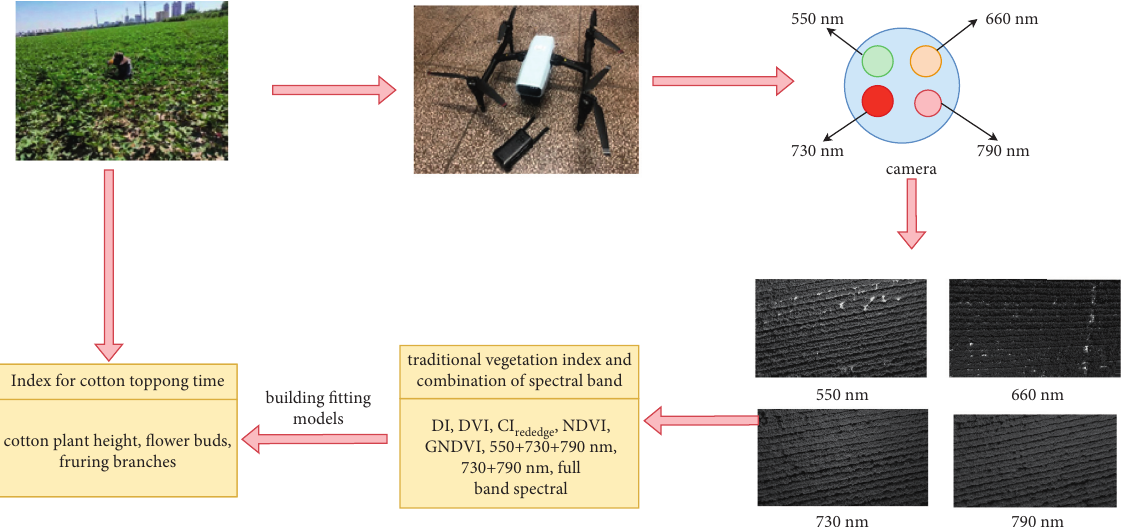
Figure 1: Cotton remote sensing information collection